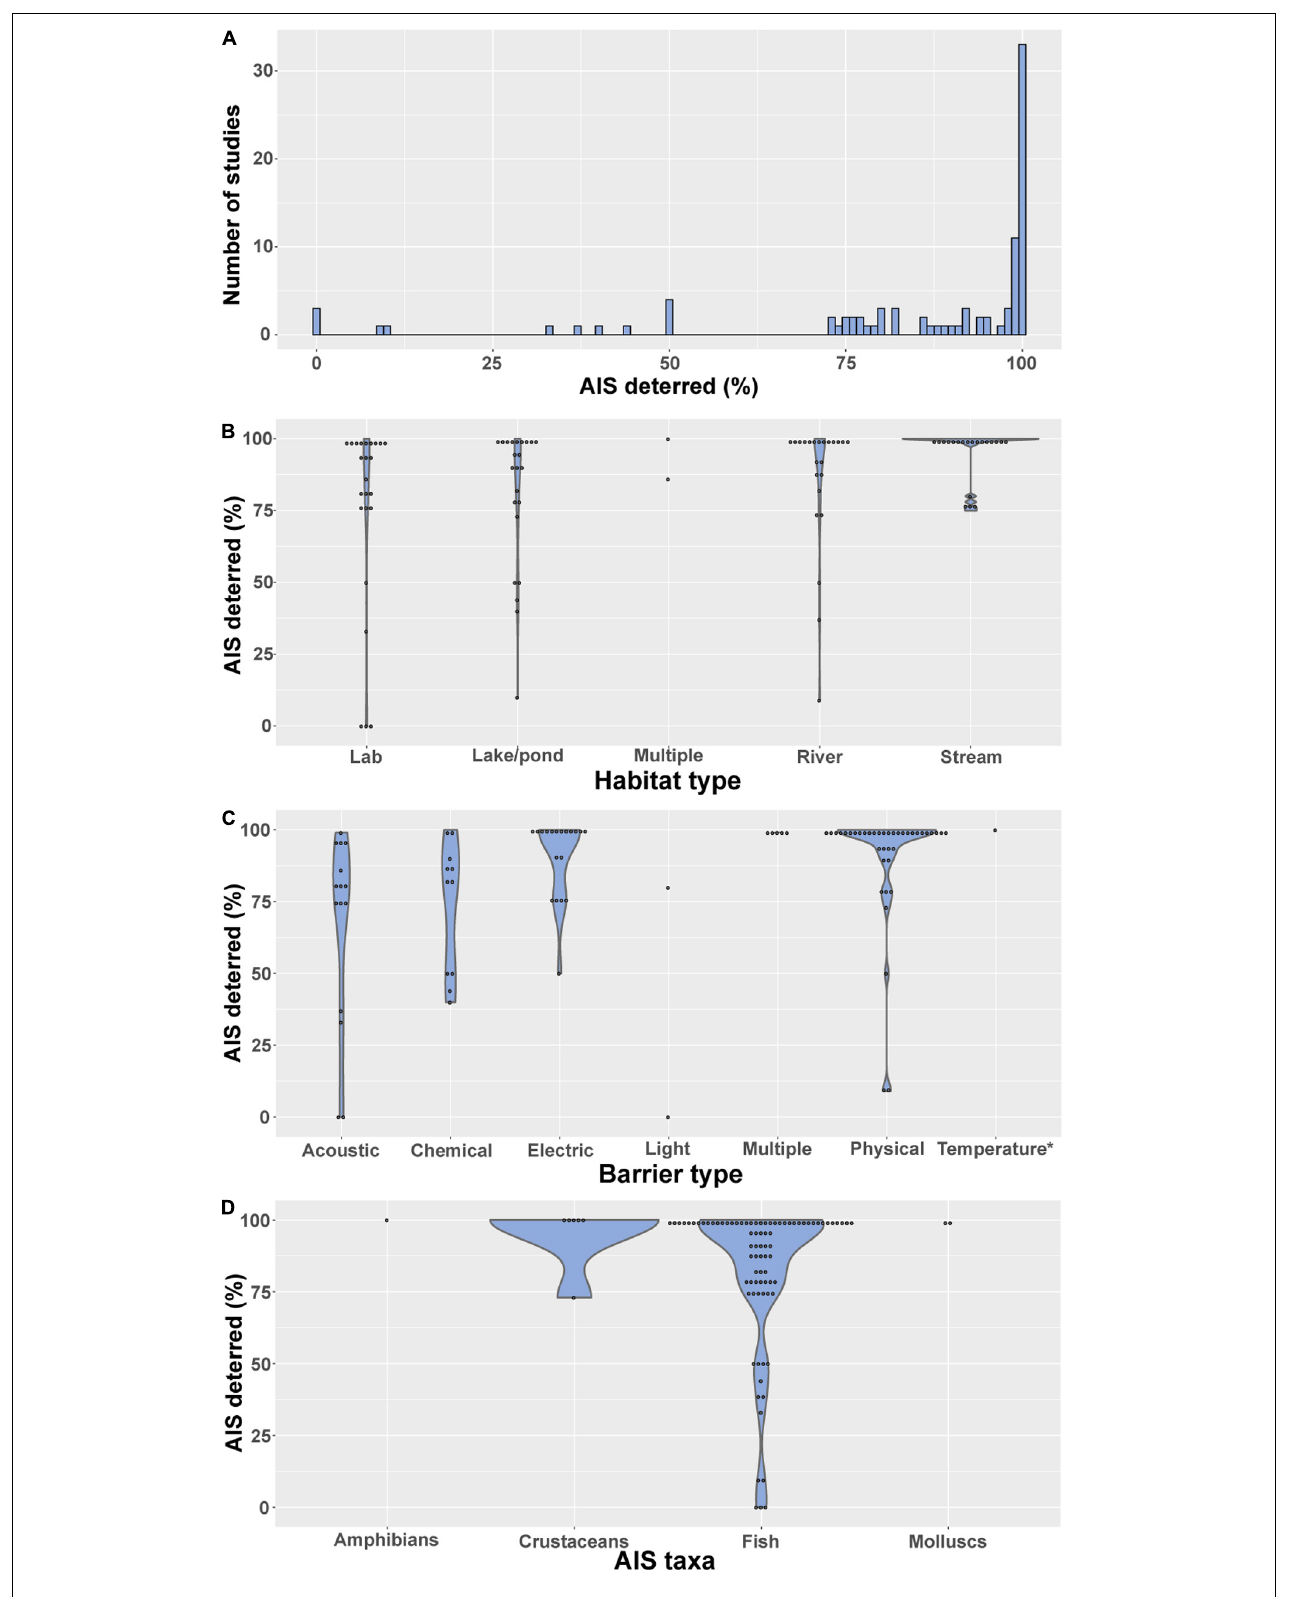
FIGURE 3 | Success rate (percentage of AIS individuals excluded) by (A) number of studies, (B) habitat type, (C) barrier type, (D) AIS taxa.